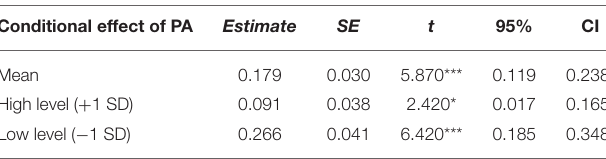
TABLE 4 | Simple slope analysis of interaction between self-determination in physical exercise and positive affect. Conditional effect of PA